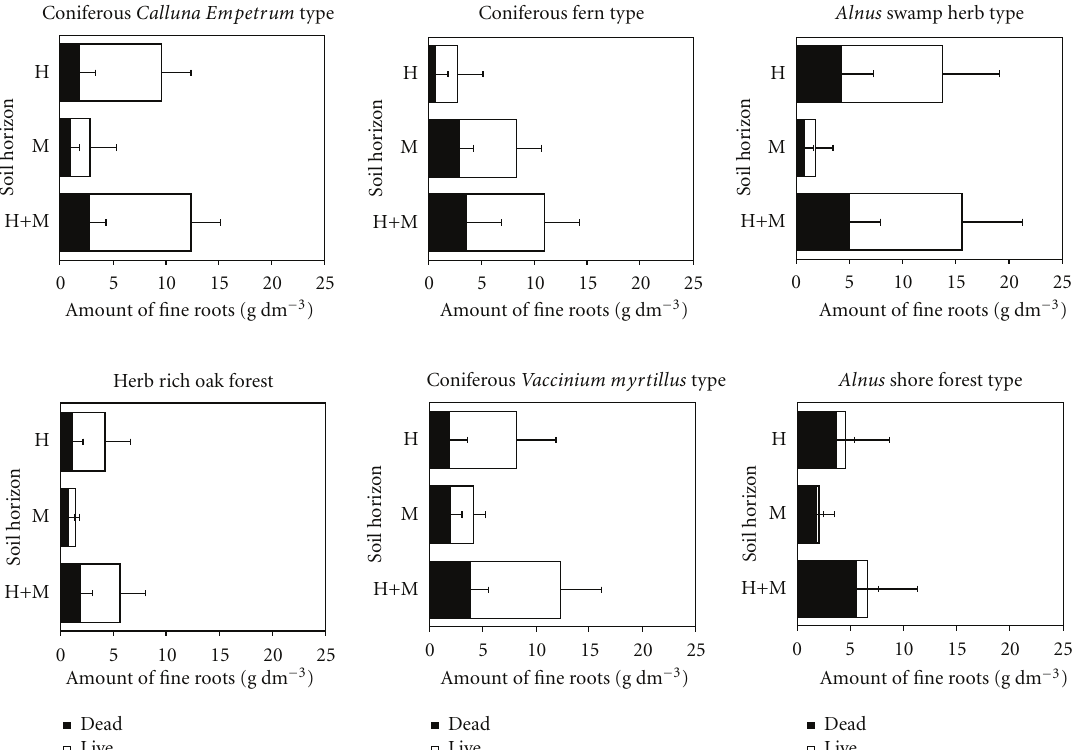
Figure 1: The amount of live and dead tree fine roots (gdm − 3 ; < 1 mm in diameter) in the humus layer (H) and in the mineral soil horizon (M) compared with in the total soil profile (H+M) at di ff erent Swedish forest sites.